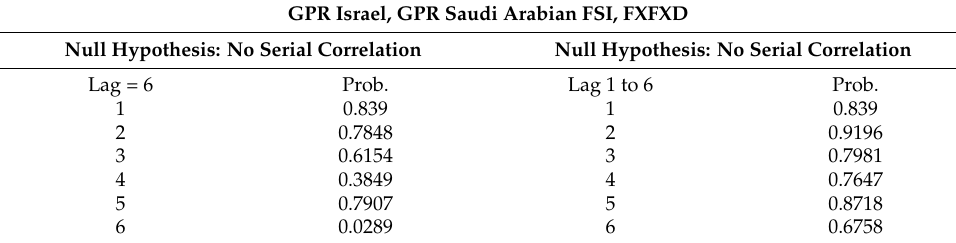
Table 10. VAR residual serial